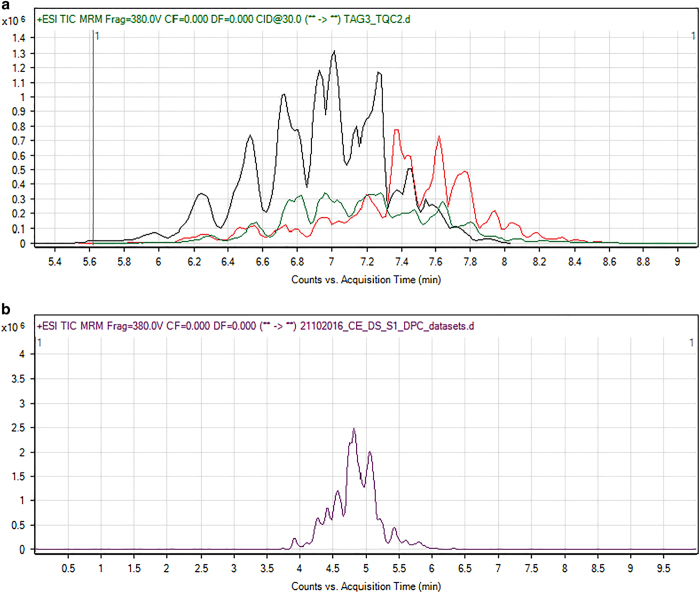
Representative chromatogram of TAG and PC lipid species with retention time.(a) Total Ion Chromatograms (TIC) of triacylglycerols detected by three different dynamic multiple reaction monitoring (dMRM) methods. Each method monitored a specific set of TAG molecular species, hence the variations in retention times between the three TICS (red, black and green). (b) A representative chromatogram showing LC separation of phosphatidylcholines from C. elegans lipid extracts. Here the x-axis is the total acquisition time (0 min to 11 min) that shows the retention time of molecular species monitored for while the y-axis represents the total ion count.